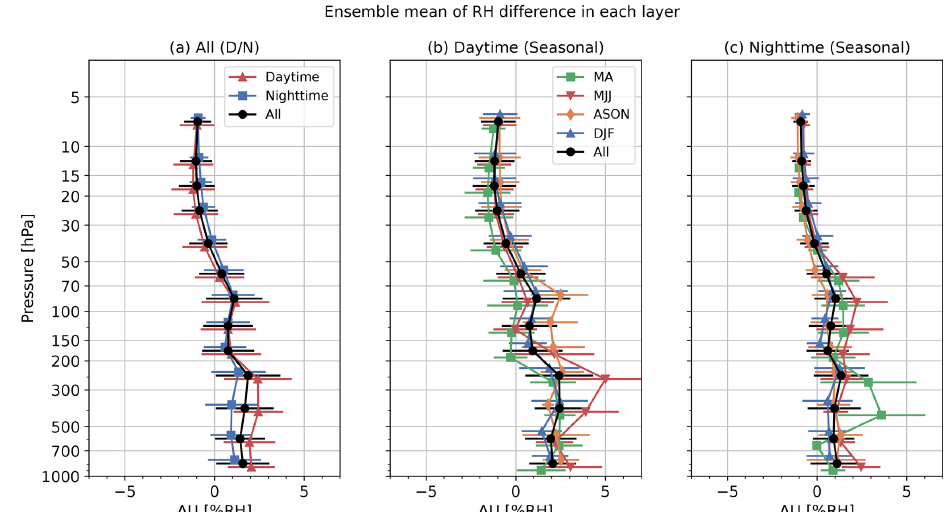
Figure 21. As per Fig. 18 but for RH.